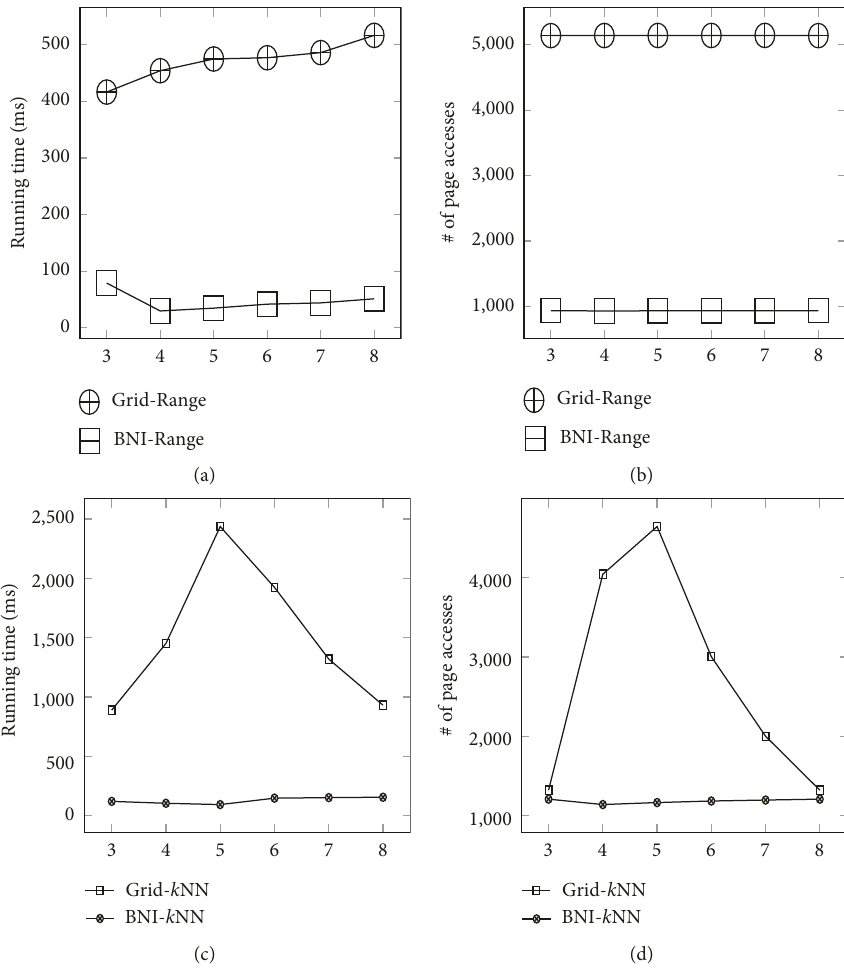
Figure 13: Effect of parameter